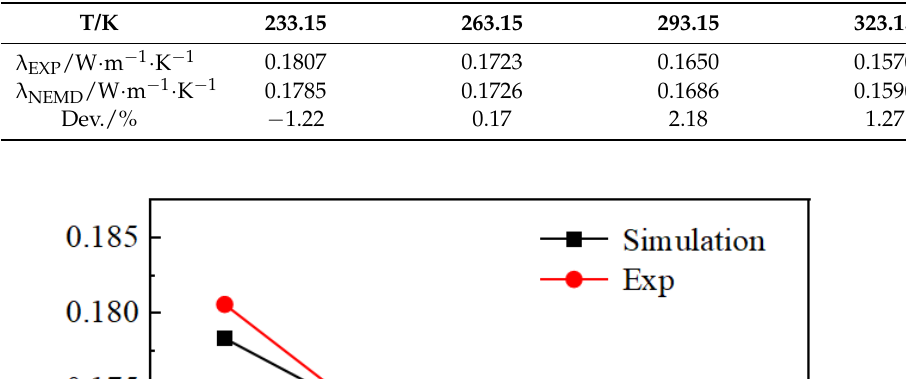
Table 5. Comparison between the simulated and experimental values of thermal conductivity for ethanol at different temperatures. T/K 233.15